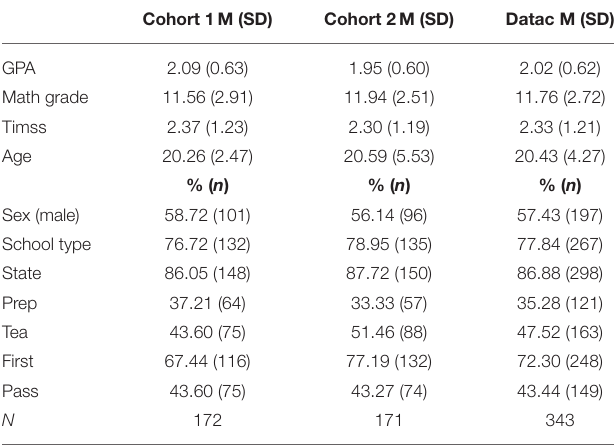
TABLE 1 | Descriptive data for cohort 1, cohort 2 and the combined data set